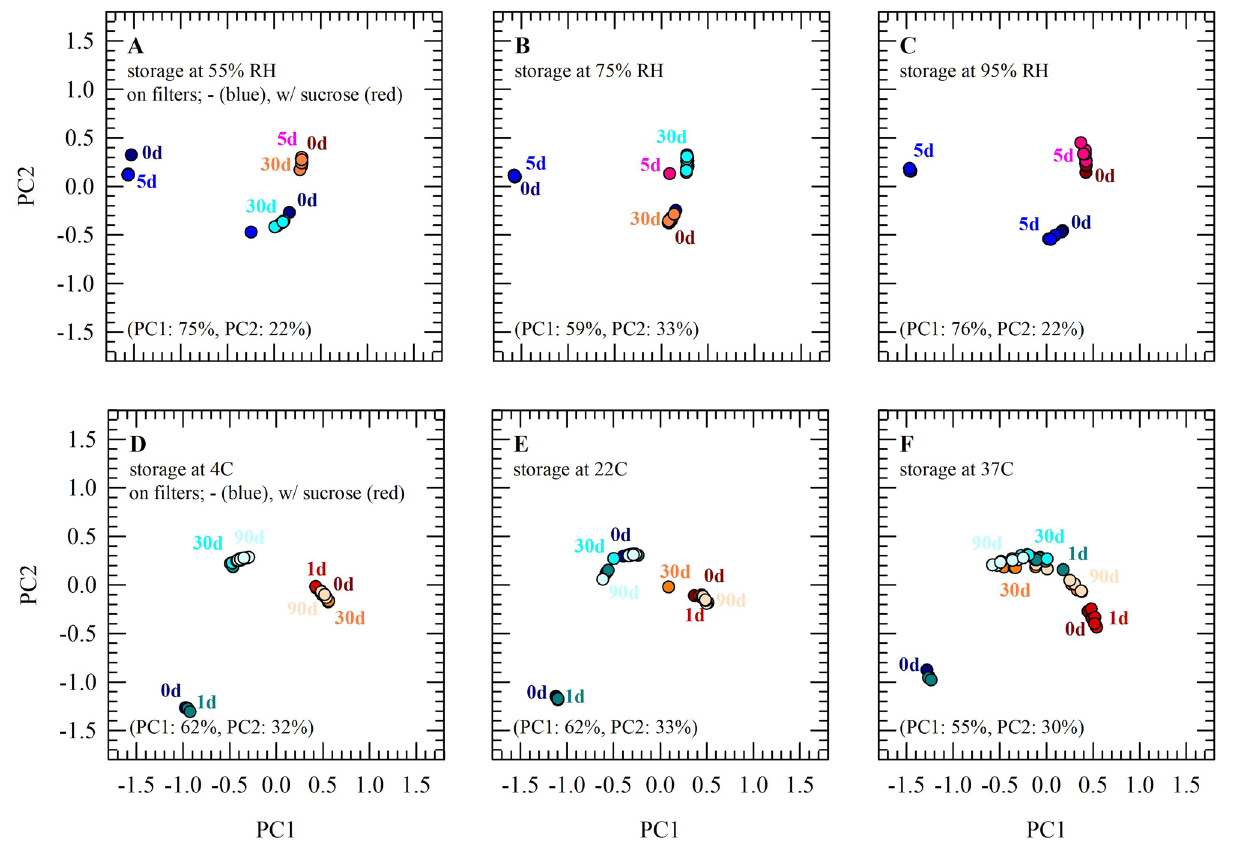
Figure 5. Principal component analysis of spectra obtained for saliva dried with(out) sucrose on filters during storage. PCA was performed for the fingerprint region (1400 − 900 cm −1 ), after vector normalization of the spectra. Saliva was dried without supplements (blue symbols) or with 10% sucrose (red/orange symbols), and stored for up to 90 d (lighter colors for later time points). Specimens were stored at 22 °C under different relative humidity ( A : 50% RH, B : 75% RH, C : 95% RH). Furthermore, specimens were sealed under ambient conditions and stored at different temperatures ( D : 4 °C, E : 22 °C, F : 37 °C). Pooled saliva was used from three different donors. All measurements were performed using six sample aliquots per treatment